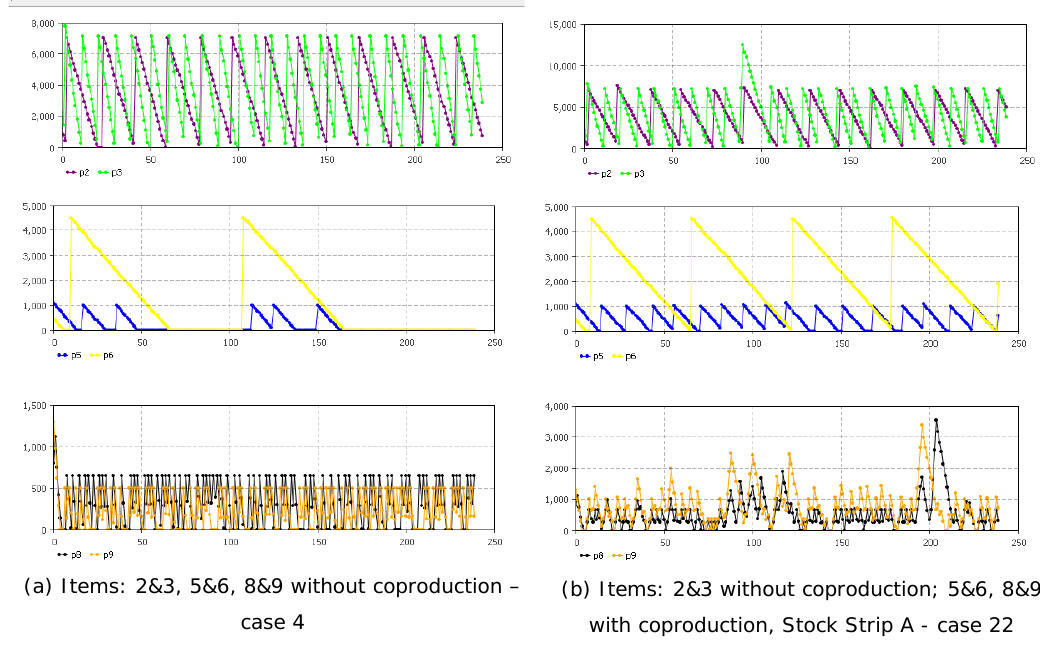
Figure 1. “Impact of Coproduction addition to stocks in the modified EMQ